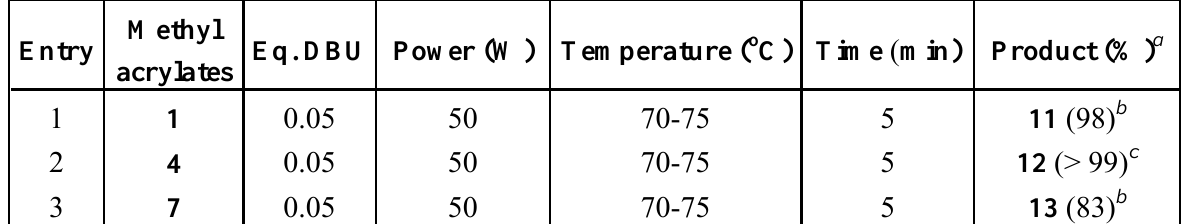
Table 3 . Addition of nitroethane ( 10 ) to different methyl acrylates ( 1 , 4 , and 7 ).